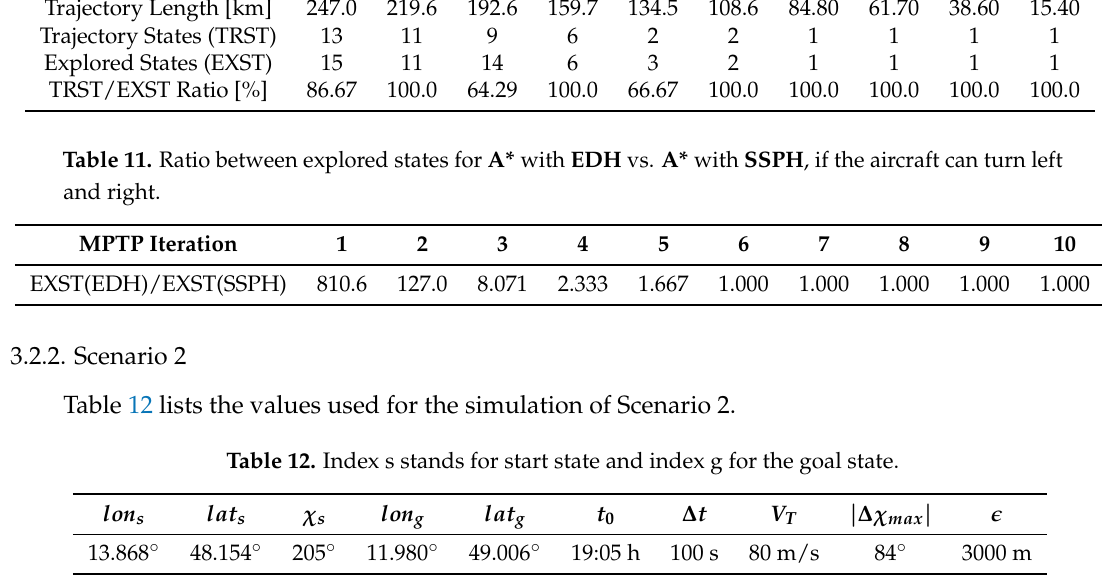
Table 9. A* using EDH applied to the avoidance in Figure 11, if the aircraft can turn left and right. MPTP Iteration Trajectory Length [km] Trajectory States (TRST) Explored States (EXST) TRST/EXST Ratio [%] Table 10. A* using SSPH applied to the avoidance in Figure 11, if the aircraft can turn left and right. MPTP Iteration Trajectory Length [km] Trajectory States (TRST) Explored States (EXST)